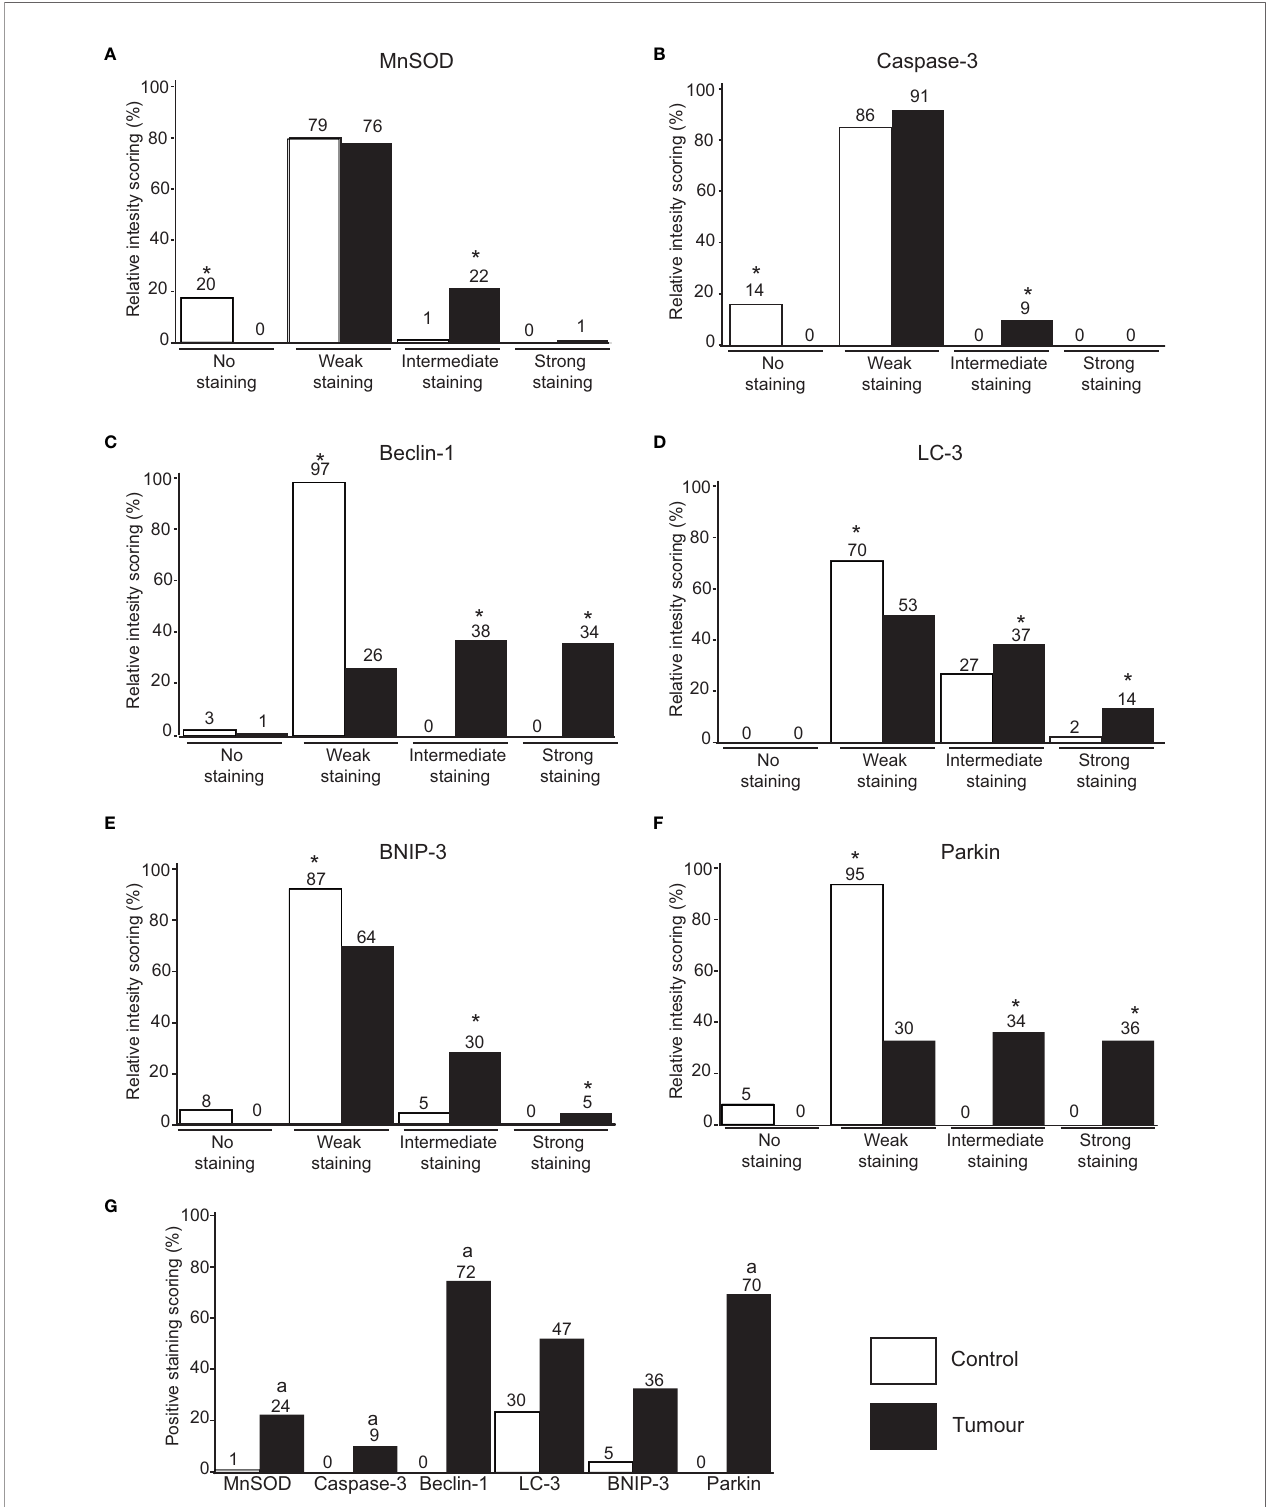
FIGURE 4 | Immunohistochemical staining intensity score of MnSOD, cleaved caspase-3, Beclin-1, LC-3, BNIP-3, and Parkin in breast tumor tissues. Immunohistochemistry intensity score of MnSOD (A) , cleaved caspase-3 (B) , Beclin-1 (C) , LC-3 (D) , BNIP-3 (E) , and Parkin (F) in breast tissue. * p < 0.05 between all group pairs of samples. (G) The immunohistochemistry scoring intensity was further classi fi ed into tissues with positive staining (intermediate and strong staining) for all protein markers. a p < 0.05 signi fi cantly lower staining between the protein